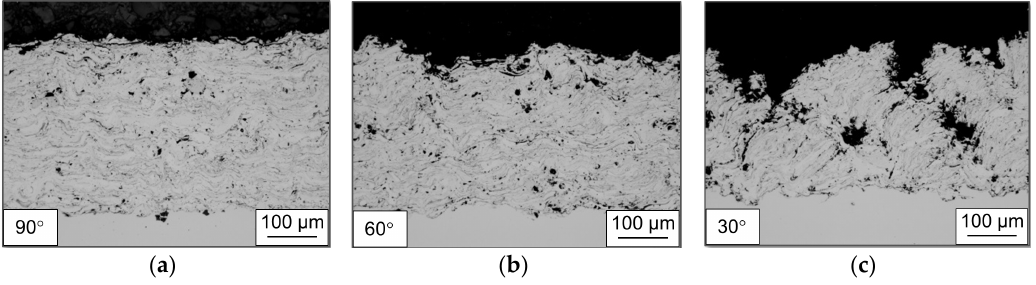
Figure 4. Cross ‐ section images taken by optical microscopy, showing the microstructure of the coating, deposited by using different spray angles: ( a ) 90°; ( b ) 60°; ( c ) 30°.